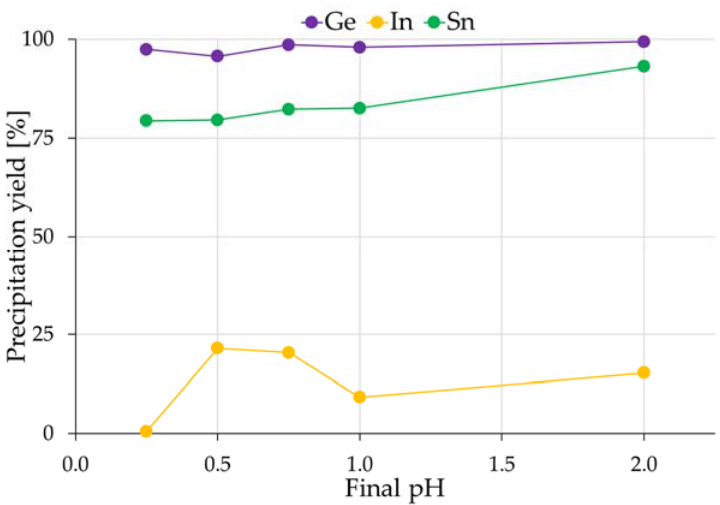
Figure 2. Influence of final pH on precipitation yields of Ge, In, and Sn (60 °C, 2 h, 100 g/dm 3 Zn used, 6 g/dm 3 Sn in initial solution).